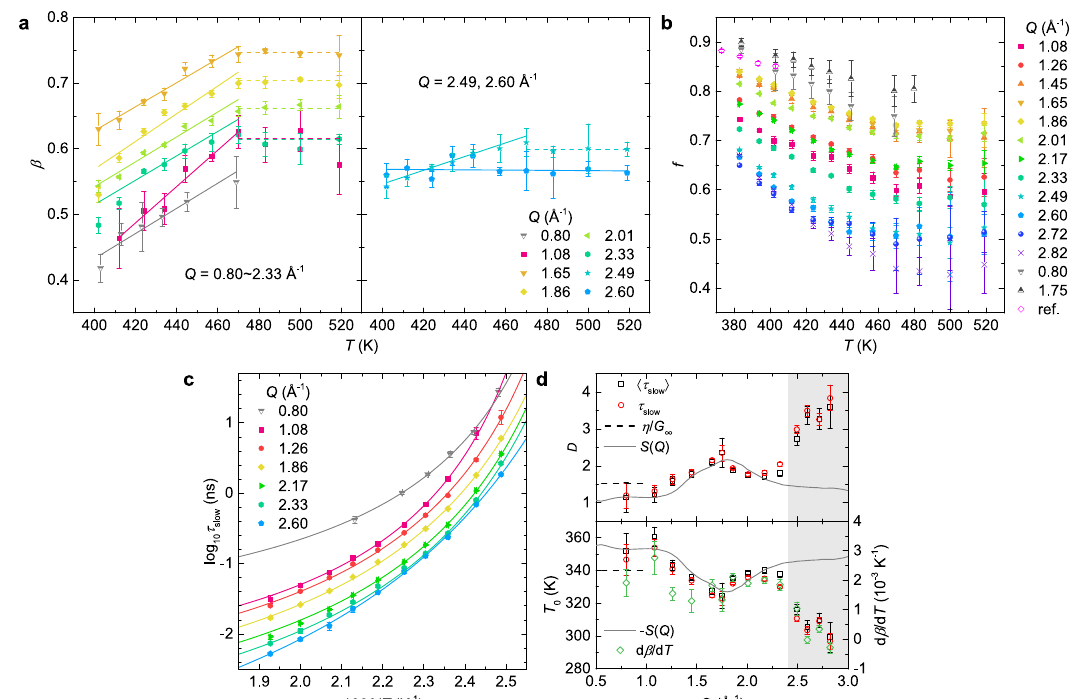
Fig. 4 Temperature behavior of the relaxation dynamics at different length scales. a Exponent β as a function of temperature (left panel: Q = 0.80 Å − 1 to 2.33 Å − 1 , right panel: Q = 2.49 Å − 1 and 2.60 Å − 1 , solid lines are representative linear fi t and dash lines are guide for the eye). b Temperature dependence of effective Debye – Waller factor f at various Q ’ s. The open diamonds are adapted from Ref. 30 at Q = 1.86 Å − 1 . c Logarithmic relaxation time τ slow as a function of 1000/ T with VFT fi ts (Eq. (2)). To make it easier for the reader to discern the curves, the data for only representative Q ’ s are shown in a and c , the rest of the data can be found in Supplementary Figs. 5 and 6. The half- fi lled triangles in a – c represent the results measured on NGA-NSE. d Q -dependence of D (upper panel) and T 0 (lower panel) obtained from the VFT fi t to τ slow (red circles), 〈 τ slow 〉 (black squares), and the macroscopic shear relaxation time 〈 τ 〉 = η / G ∞ (dash lines) [see Supplementary Figs. 7a and 9 for the VFT fi t to 〈 τ 〉 and 〈 τ slow 〉 ], diamonds in the lower panel are Q -dependence of d β = d T (right axis). The solid line in the upper panel of d is the static structure factor S ( Q ) measured at T = 480 K, and that in the lower panel is − S ( Q ). Error bars represent one standard error and where not seen they are smaller than the symbol size. Source data are provided as a Source Data fi